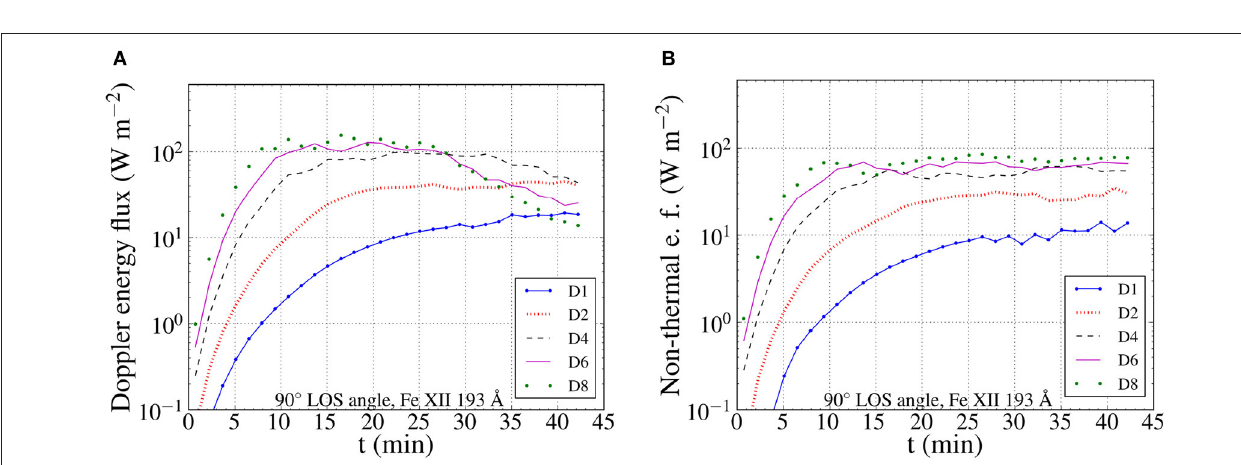
Doppler energy flux is the combined result of the input drop and the loop deformation by the TWIKH